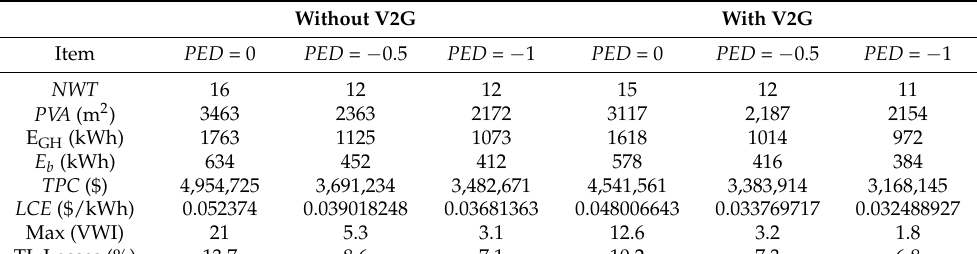
Table 4. The change in system size components with different values of PED , 0 (flat tariff), − 0.5, − 1, respectively.